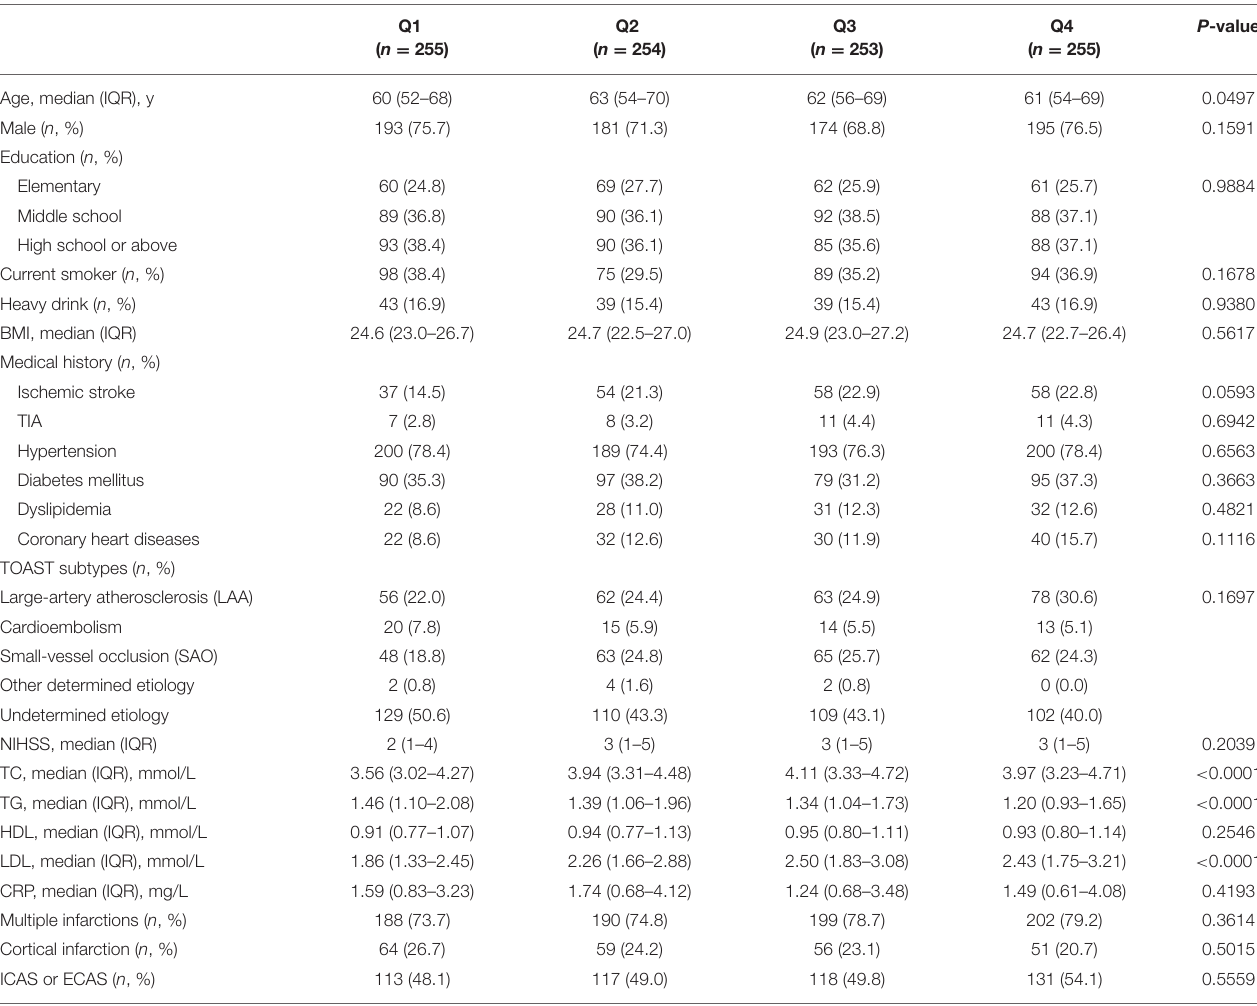
TABLE 1 | Baseline characteristics according to Lp(a)